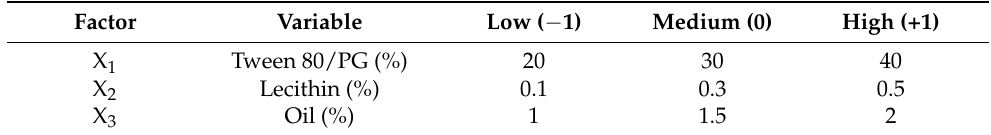
Table 2. Factorial plan for microemulsions with three independent variables and three levels of variation, coded for each factor; and dependent variables for study of the optimization process. Factor Variable Low ( − 1) Medium (0) High (+1) X 1 Tween 80/PG (%) Lecithin (%) 0.1 0.3 Oil (%)